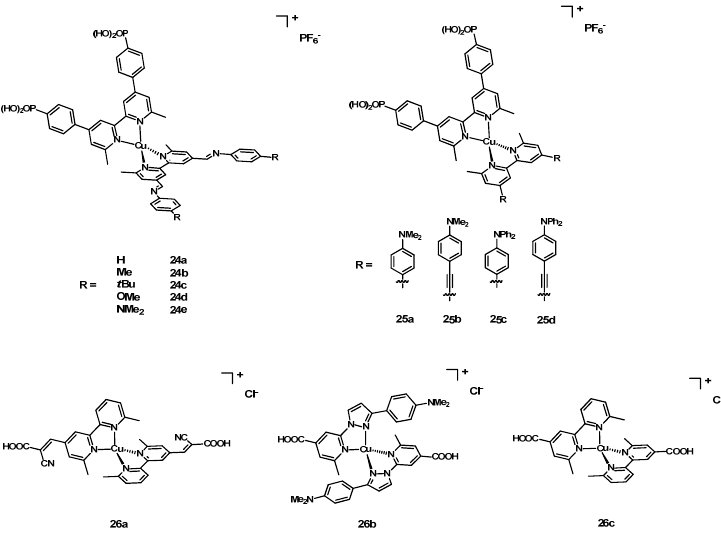
Figure 11. Structure of dyes 24a – e , 25a – d, and 26a – c . By comparing the photovoltaic parameters, it was clear that the introduction of the al- kynyl group was not beneficial to the performances, since both the Jsc and the Voc achieved lower values (474 mA cm − 2 and 539 mV for 25a ; 3.59 mA cm − 2 and 514 mV for 25b ). The same trend arose from dyes 25c and 25d , confirming the negative effect of the alkynyl moiety on the cell parameters. Table 5, entries 56–77, reports the data for the produced solar cells.